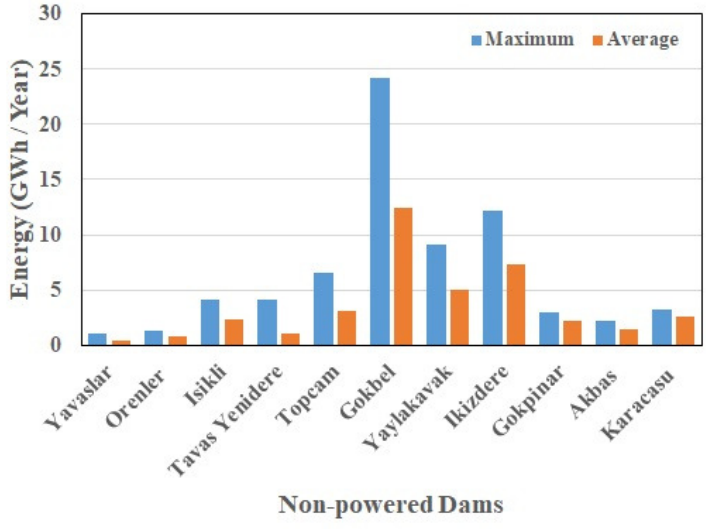
Figure 3. Annual maximum and average energy production for Scenario 1 of the 11 NPDs.